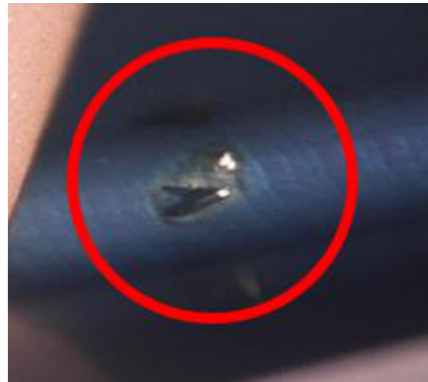
Figure 3. Bound chip on the tooth involute surface, after power skiving machining.